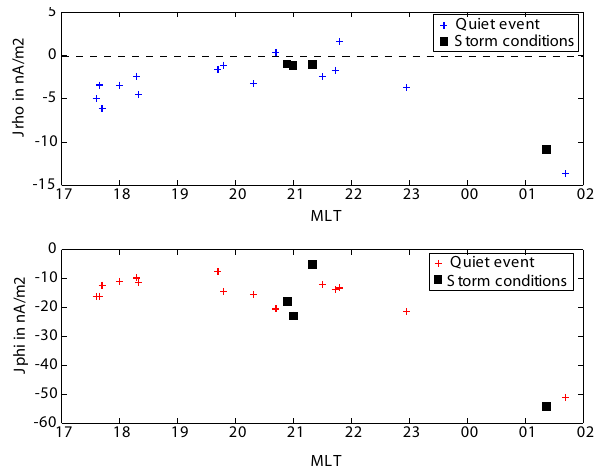
Fig. 16. Radial and azimuthal components of the current for the February − June 2002 Cluster perigee passes, as a function of the magnetic longitude, for the − 30 ◦ to 30 ◦ latitude interval, and pro- jected down to the equatorial plane. Blue and red crosses represent the quiet events and black squares correspond to storm-time